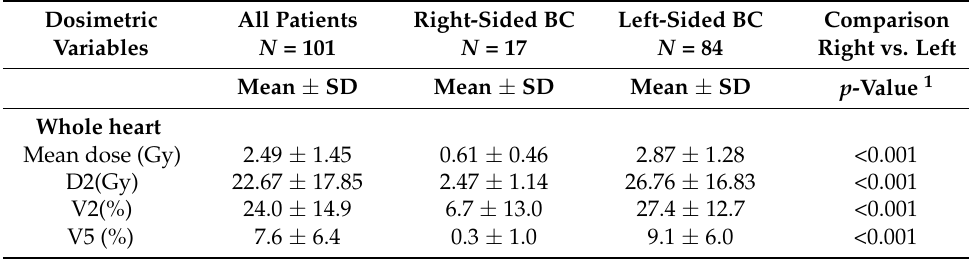
Table 2. Description of cardiac mean doses and dose–volume histogram parameters.